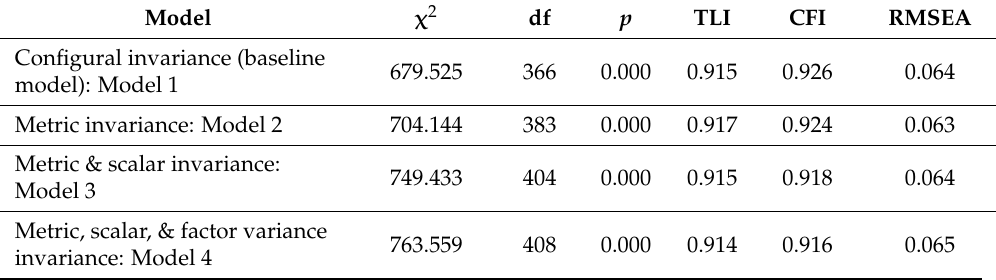
Table 2. Fit indices for construct equivalence Tests.